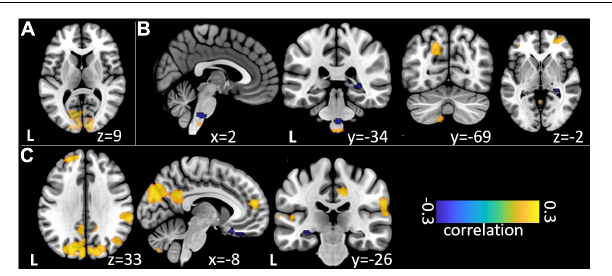
EEG SSVEP and fMRI during repetitive visual stimulation. (B) Relation of theta/delta and (C) high gamma EEG time-frequency windows during trigeminal